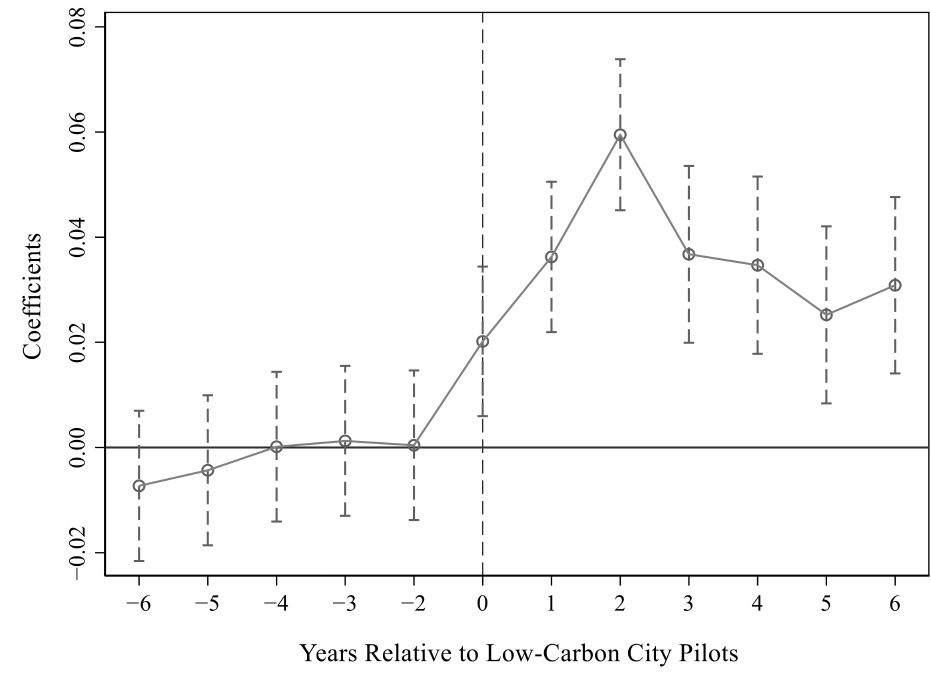
Figure 2. Parallel trend test in the second column of Table 3.